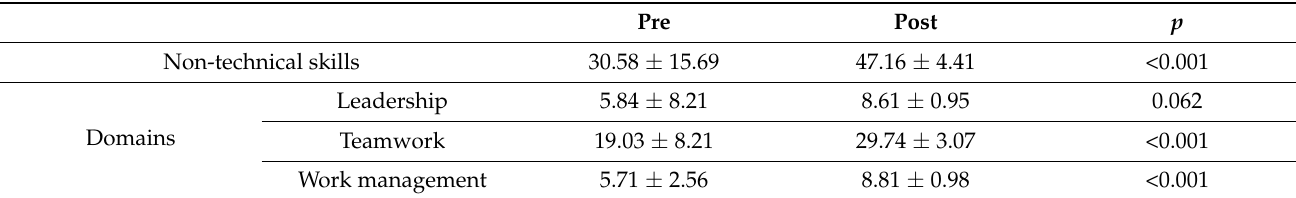
Table 3. Differences in non-technical skill scores before and after undergoing Korean Advanced Life Support training ( n =